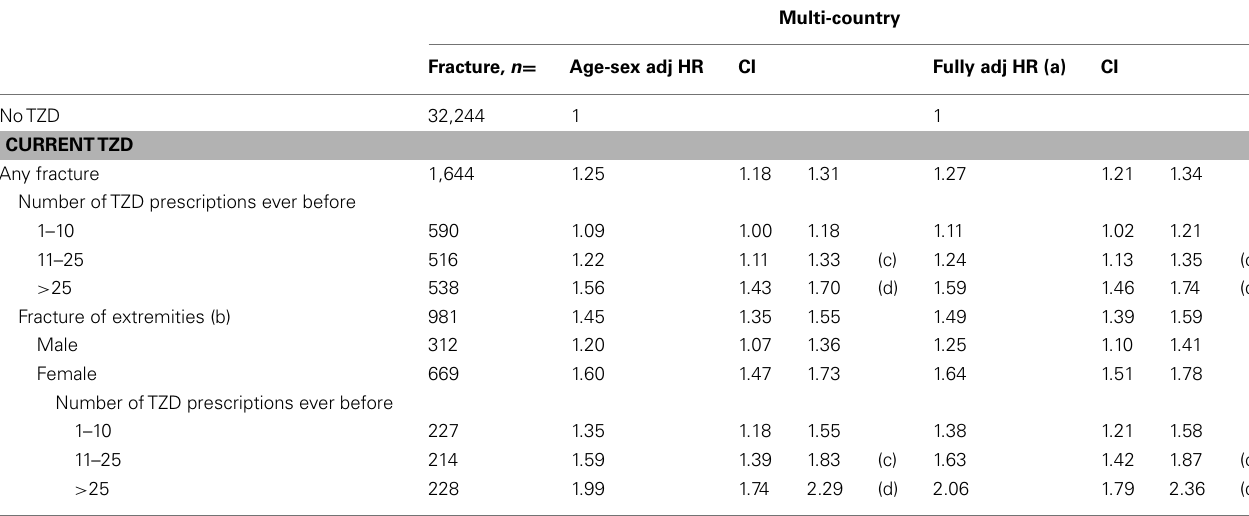
Table 6 | Multi-country: risk of fracture in currentTZD users compared with other antidiabetic users, by number ofTZD prescriptions.